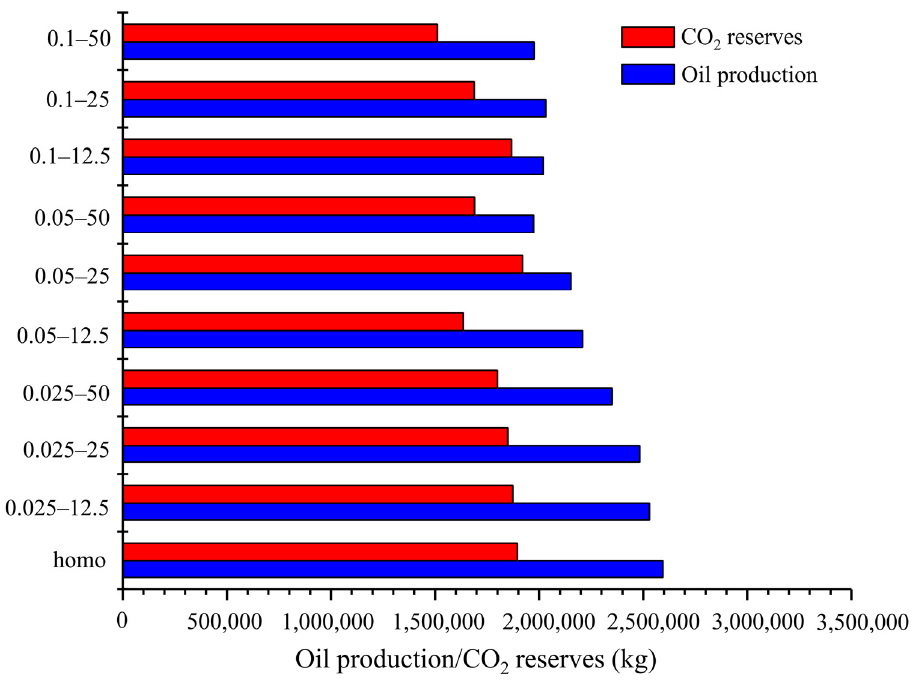
Figure 10. CO 2 reserves and oil production statistics of each